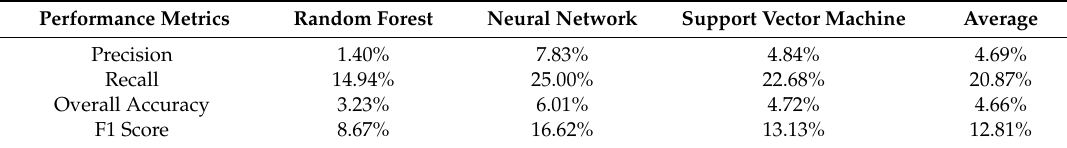
Figure 13. Classification accuracies by random forest, neural network, and support vector machine for lodging detection on three different dates datasets, where PER, REC, OAC, and F1 denote precision, recall, overall accuracy, and F1 measurement, respectively. Table 1. Accuracy fluctuation of four parameters for three classifiers. Table 1. Accuracy fluctuation of four parameters for three classifiers.